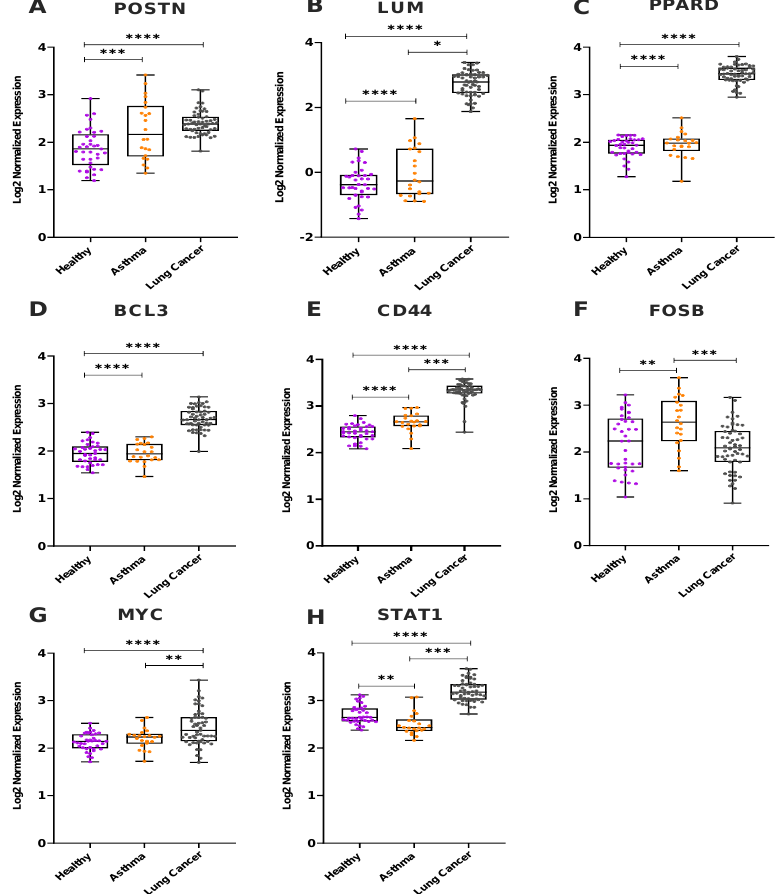
Figure 7. Boxplots for the differentially expressed genes in severe asthma and lung cancer from Microarray dataset. ( A ) POSTN ( B ) LUM ( C ) PPARD ( D ) BCL3 ( E ) CD44 ( F ) FOSB ( G ) MYC ( H ) STAT1 (Mann − Whitney test, * p < 0.05, ** p < 0.01, *** p < 0.001, **** p < 0.0001).